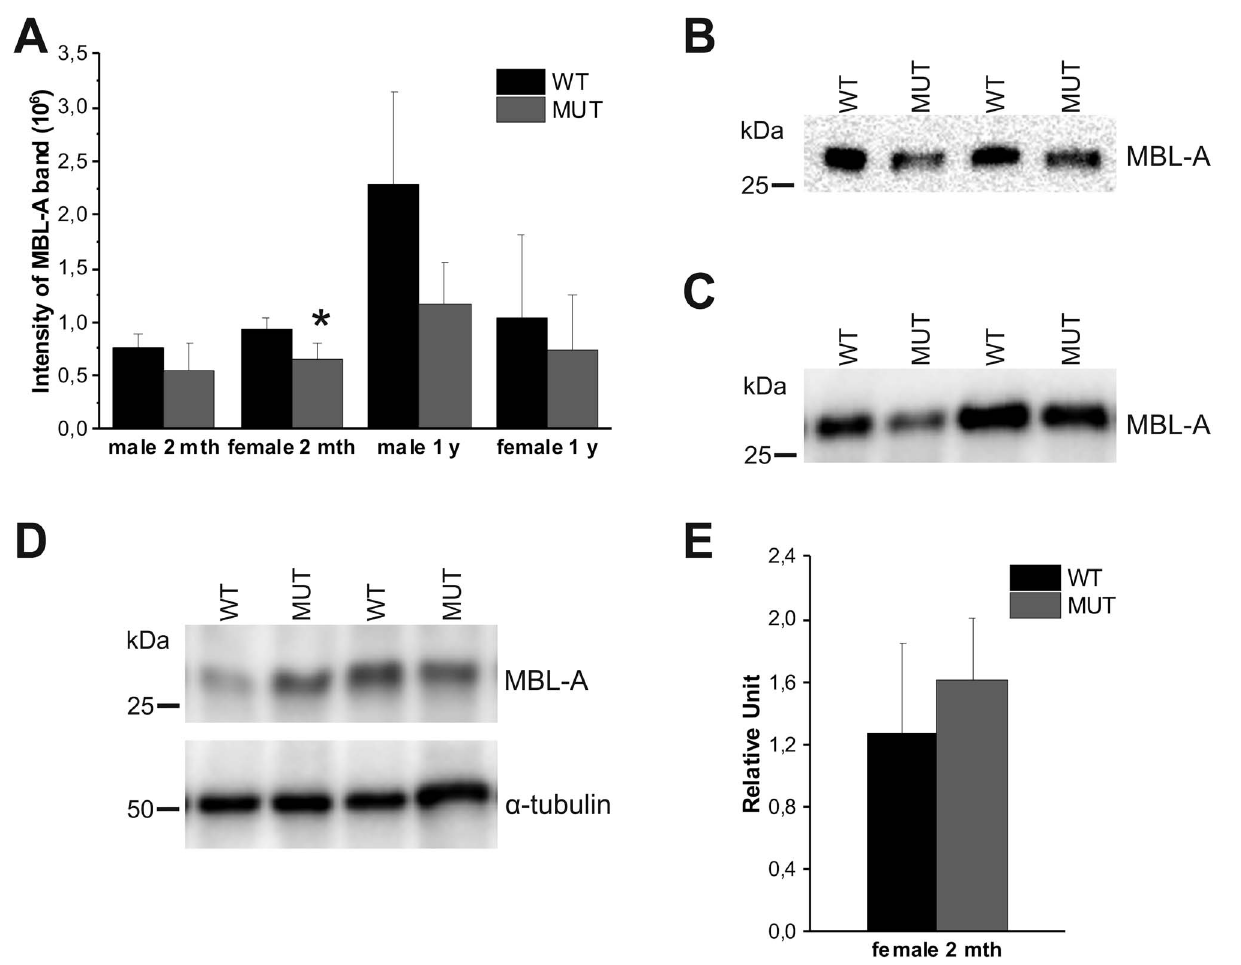
Figure 3. Amount of MBL-A in serum and liver of LH mutant mice. (A) Amount of MBL-A was reduced in the serum of LH mutant mice (MUT) compared with the corresponding wild type mice (WT). Amount of MBL-A was analyzed from the serum of the 2 months old male (n 5 4 WT, 4 MUT) and female (n 5 4 WT, 4 MUT) and 1 year old male (n 5 4 WT, 3 MUT) and female (n 5 5 WT, 6 MUT) by immunoblots. The values represent the average ¡ SD of the samples. MBL-A monomers in the serum of 2 months old female (B) and 1 year old male (C) wild type and LH mutant mice did not show significant differences in electrophoretic mobility. (D) The immunoblot analysis of liver homogenate (40 m g of soluble protein) of wild type and LH mutant male mice did not show differences in mobility of MBL-A monomers. (E) The amount of MBL-A in liver of LH mutant mice is higher than in wild type. Amount of MBL-A in liver was analyzed with immunoblots and a -tubulin was used as control to normalize the quantities of protein. In immunoblots B, C and D two representative wild type and LH samples are shown. MBL-A in LH mutant mice does not show doublet band, differing from the results of rat MBL-A overexpressed in cell culture system (Fig. 1A). The values in figure A and E represent the average ¡ SD of the samples. P values were calculated using unpaired homoscedastic student t-test with two-tailed distribution. * p ,